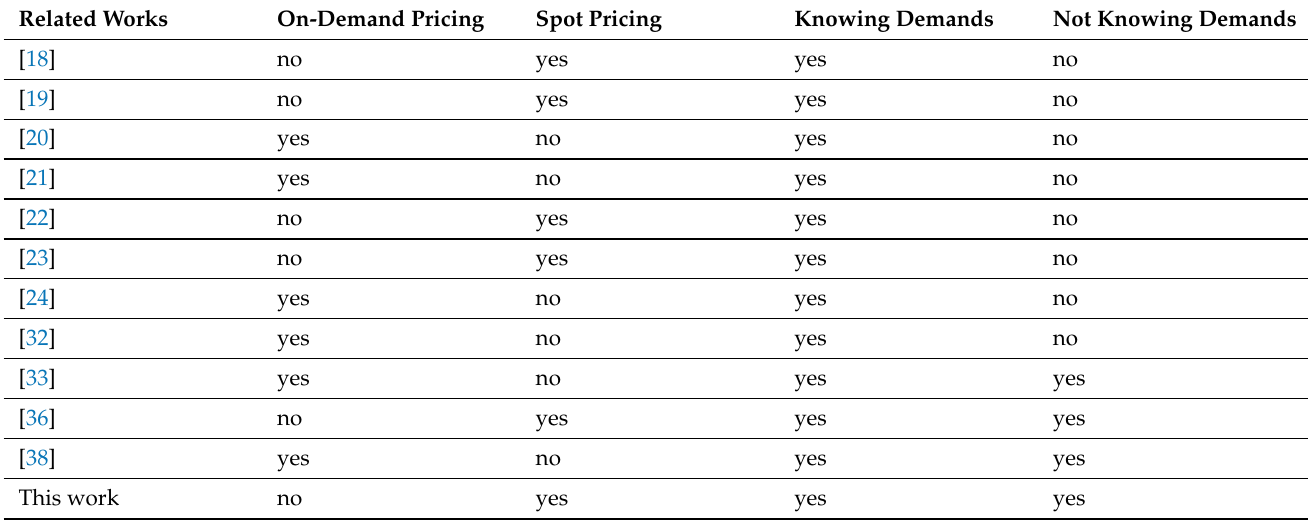
Table 1. Brief comparison of resource provisioning policies in public